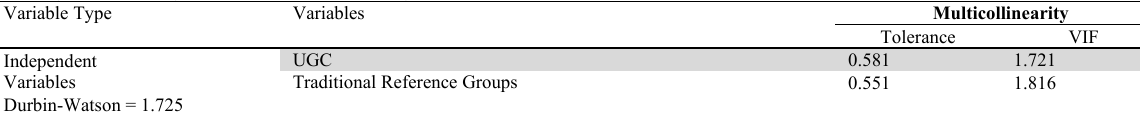
Validity of the study data for statistical analysis Variable